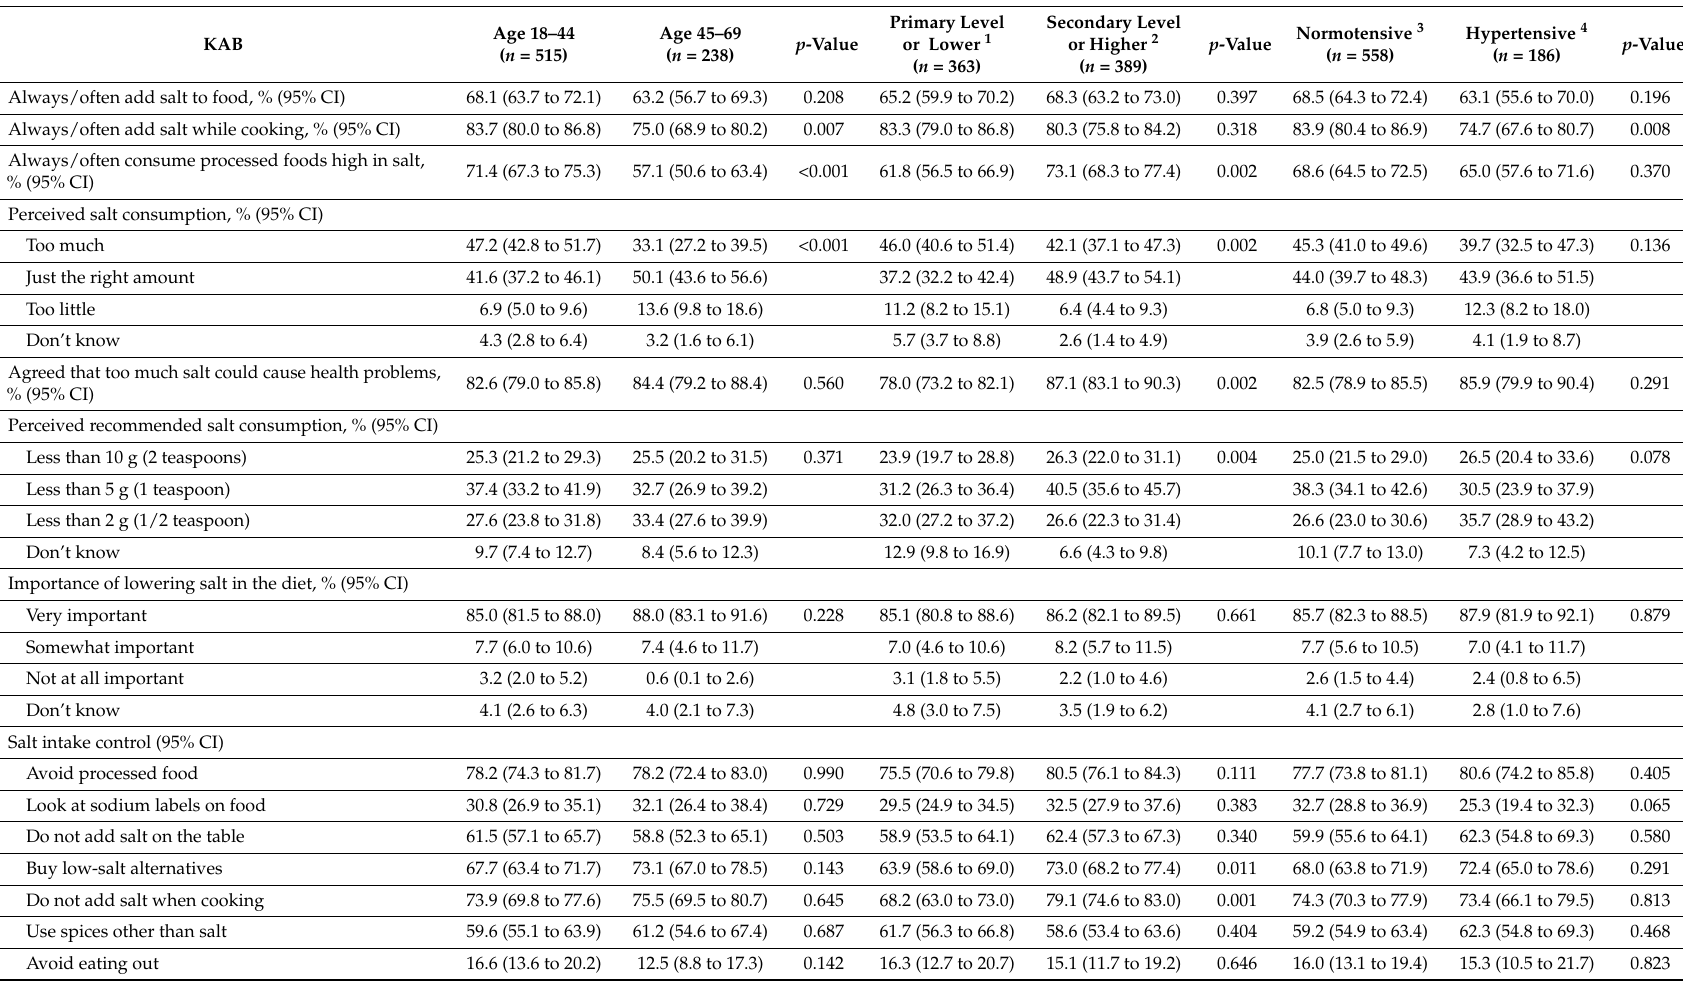
Table 3. Weighted knowledge, attitudes and behaviors (KAB): Results of subgroup analyses for age, education and blood pressure. Age 18–44 KAB ( n =